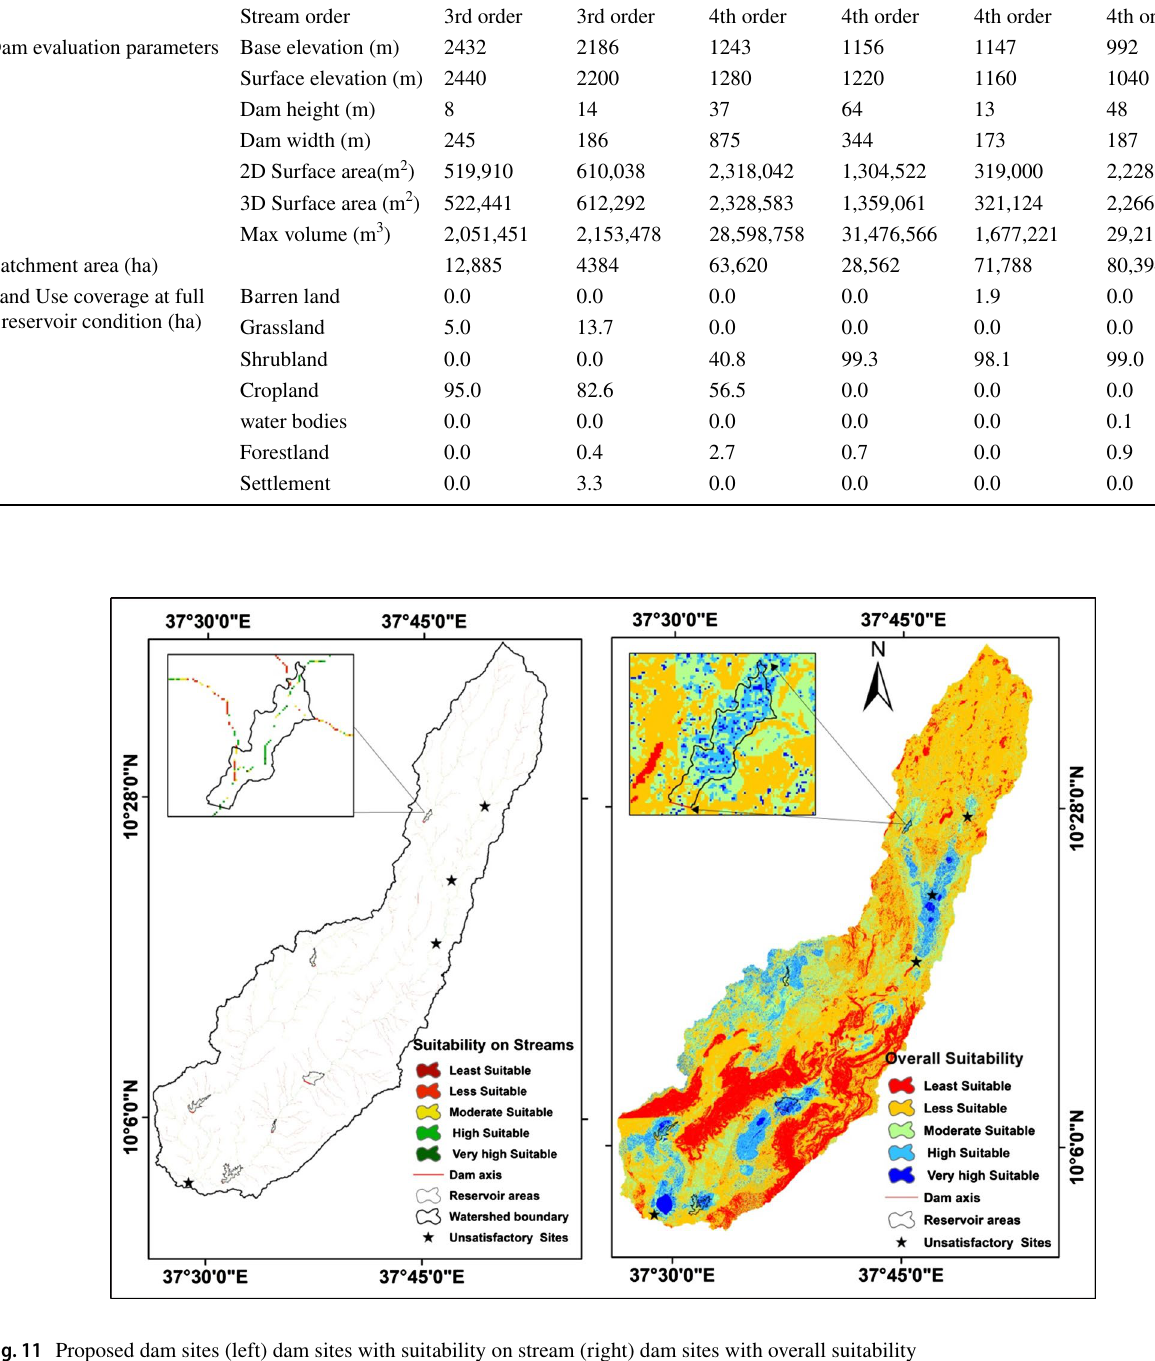
Fig. 11 Proposed dam sites (left) dam sites with suitability on stream (right) dam sites with overall